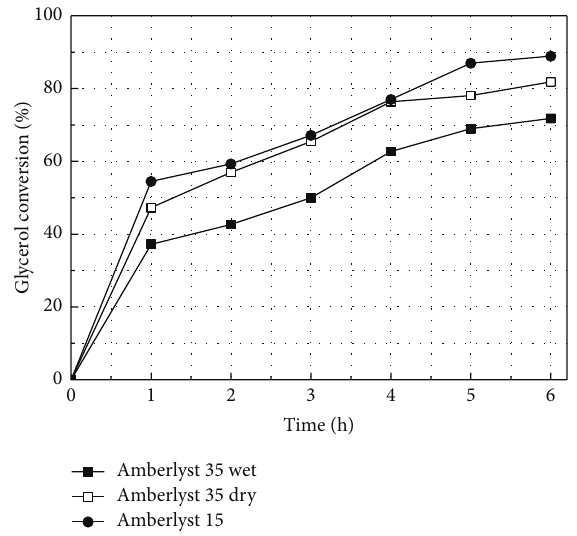
Figure 2: Influence of the different catalysts on glycerol conversion. Reaction conditions: 70 ∘ C, TBA to glycerol molar ratio = 4 :1, catalyst loading = 7.5 wt.% to glycerol, and 8